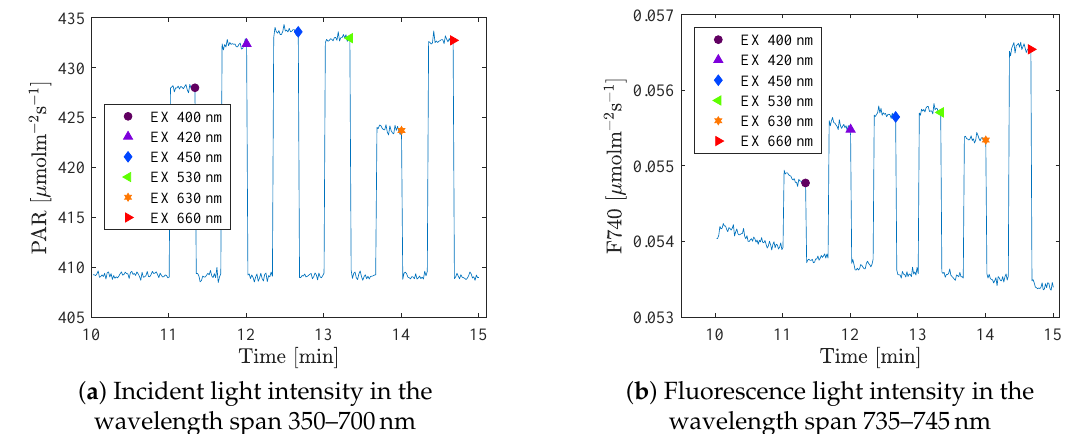
Figure A2. Measurements on cucumber, holding each intensity level at 20 s. ( a ) Incident and ( b ) fluorescence light intensity (µmolm − 2 s − 1 ) vs. time for one background light level, i.e., background intensity 500µmolm − 2 s − 1 and spectrum having 85% red light. An excitation step is sequentially added by each LED colour. Note that the intensity level measured during the experiment was only about 409 and not 500µmolm − 2 s − 1 . This is because when the light level was determined, no plants were present in the experimental unit and another type of spectrometer was used.